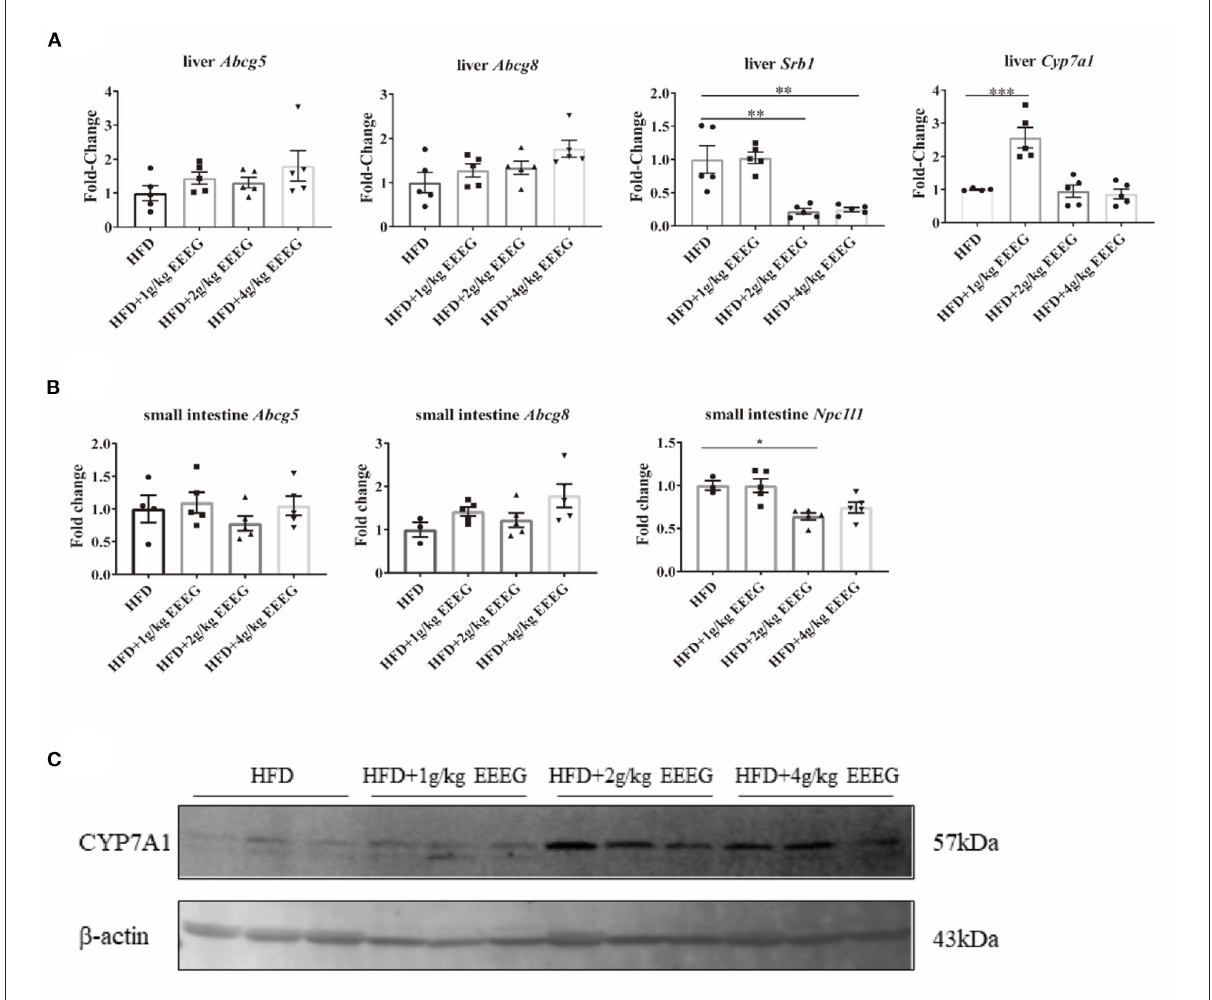
FIGURE7 EEEG reduces cholesterol absorption in the liver and small intestine of mice. (A) RT-qPCR analysis of Abcg5 , Abcg8 , Srb1 , and Cyp7a1 gene expression in liver. (B) RT-qPCR analysis of Abcg5 , Abcg81 , and Npc1l1 gene expression in the small intestine. (C) Expression of CYP7A1 in the liver of each group of mice analyzed by Western blotting. Data are expressed as mean ± s.e.m., Statistical analysis was based on Graphpad Prism 9.0.2 software and a value of P < 0.05 was considered statistically significant. One-way ANOVA with Student Neuman-Keuls post-hoc test was performed to compare the data between multiple groups, * p < 0.05, ** p < 0.01, *** p <